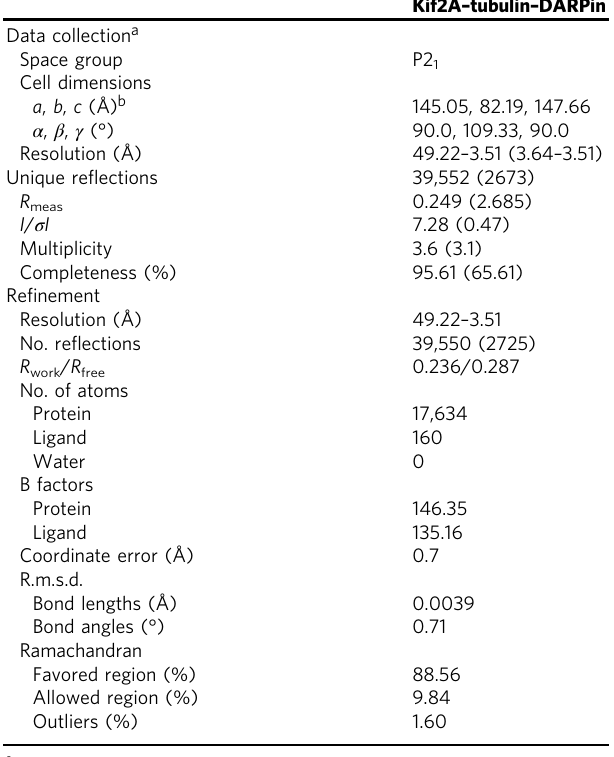
Table 1 Data collection and re fi nement